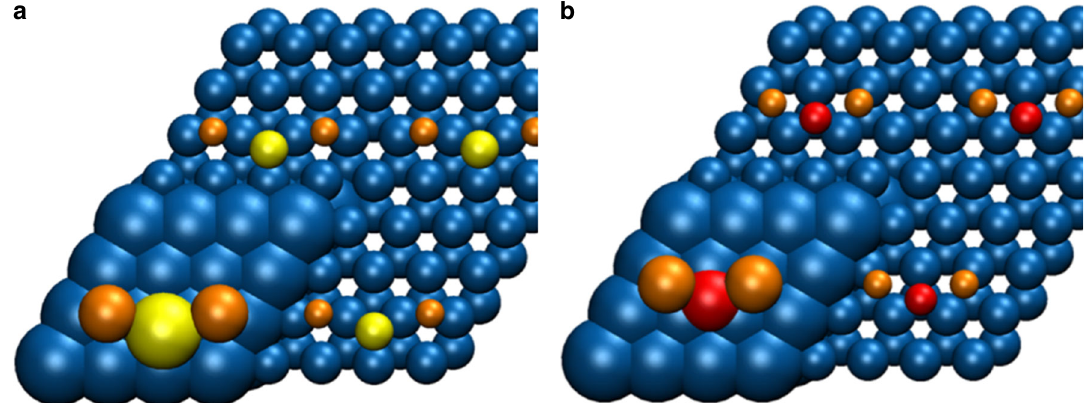
Fig. 6 DFT-calculated binding geometries of Na 2 S and Na 2 O on the Co (0001) surface. a Na 2 O and b Na 2 S bind in a very similar fashion, although the O atom ends up above a subsurface cobalt atom and the S atom above an empty site. Atoms outside the calculation unit cell are depicted as smaller spheres; blue is Co, orange is Na, yellow is S and red is O